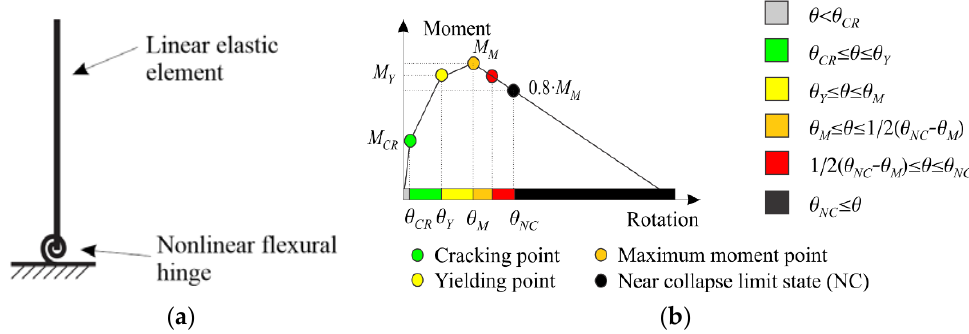
Figure 2. ( a ) mathematical model of column for simulation of cyclic response and ( b ) four-linear moment-rotation relationship of plastic